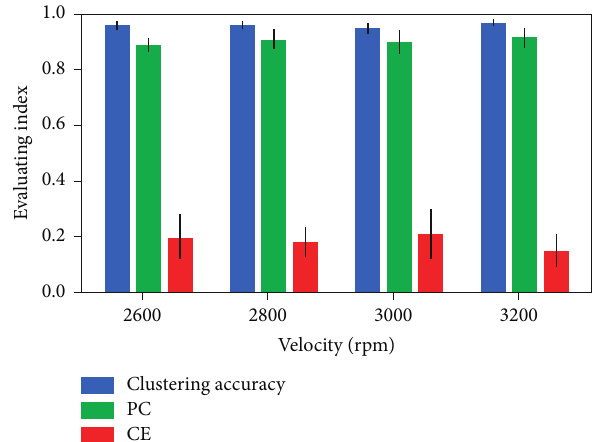
Figure 17: The performances of the proposed method at different